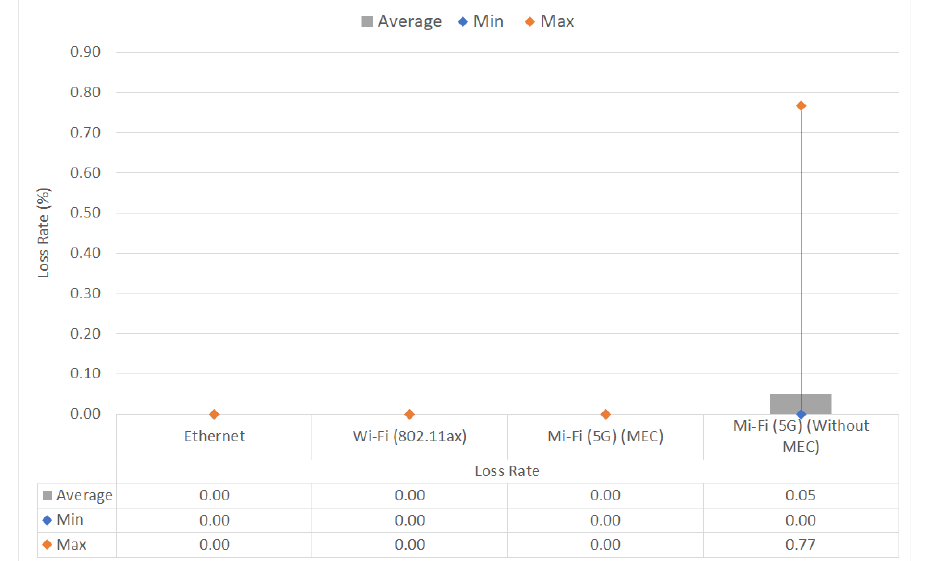
Figure 8. Multi-Access Edge Network Jitter.